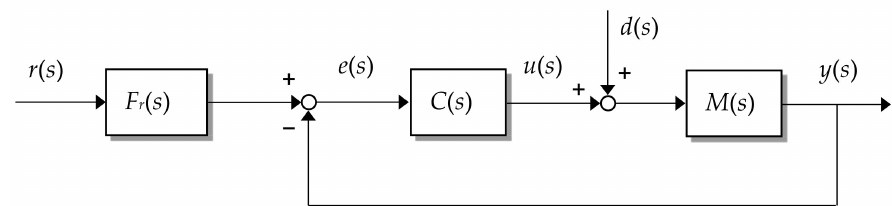
Figure 3. The structure of control system with set-point